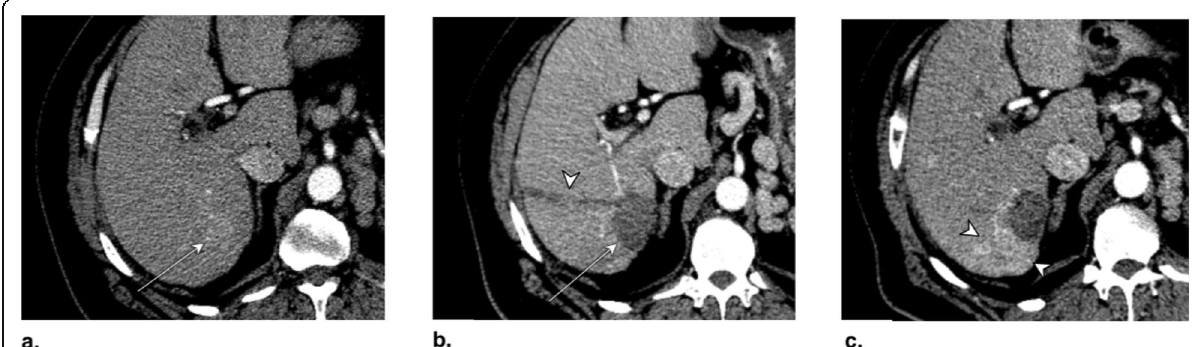
Fig. 13 Axial CT in late arterial phase obtained ( a ) pretreatment: image shows nonrim arterial phase hyperenhancement (APHE) of a right lobe LR-4 observation (arrow). b 2 months post radiofrequency ablation (RFA): image shows needle trajectory (arrowhead) and a treatment cavity (arrow) with no residual tumor. c 8 months post RFA: image shows irregular masslike APHE (arrowheads) posterior to the treatment zone. The